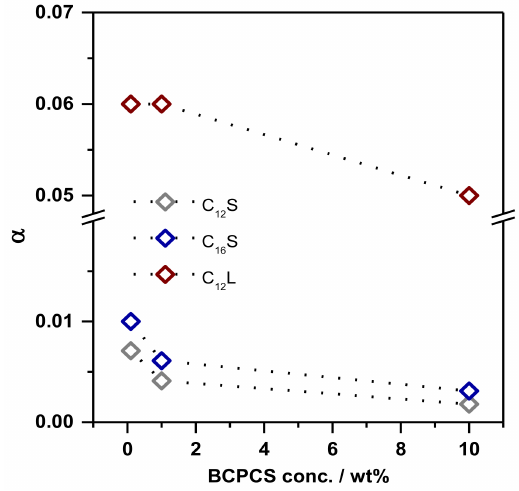
Figure 7. Fraction of dissociated surfactant ions ( α ) as a function of BCPCS concentration in the dilute phases obtained by centrifuging BCPCS samples at different overall (initial) concentrations. The lines are guides for the eye. The terms C 12 and C 16 refer to the surfactant alkyl chain length, and S and L refer to the length of the PAAm block in the BCP (short and long,